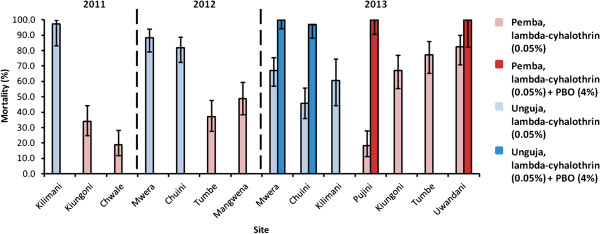
Susceptibility of An. gambiae to lambda-cyhalothrin in Zanzibar between 2011 and 2013. Mosquitoes were exposed to lambda-cyhalothrin (0.05%) in WHO susceptibility tests between 2011 and 2013. Blue (Unguja) and red (Pemba) percentage mortalities with 95% binomial confidence intervals are given one-hour of exposure to insecticide. Darker bars represent synergist assays using one-hour pre-exposure with piperonyl butoxide (PBO) performed in 2013.